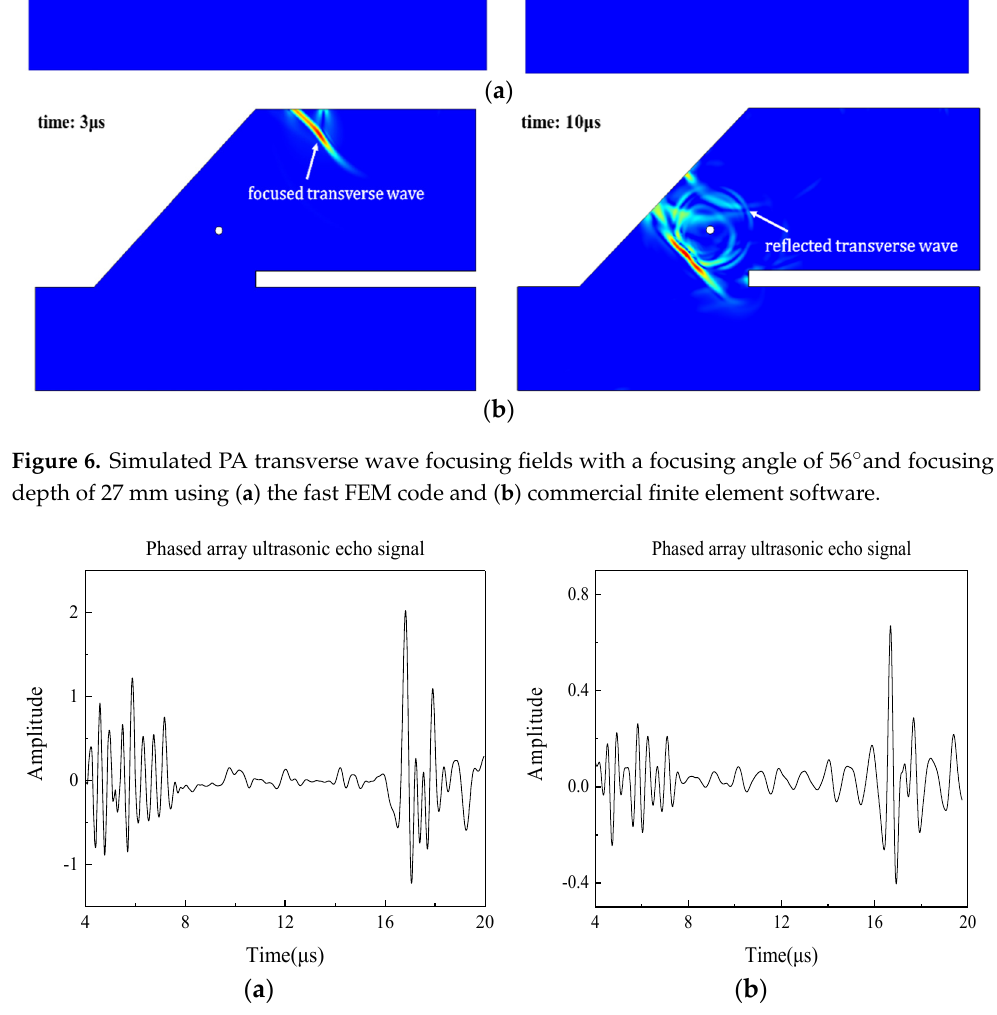
Figure 7. PA transverse wave signal of the defect simulated using ( a ) the fast FEM code and ( b ) commercial finite element software.